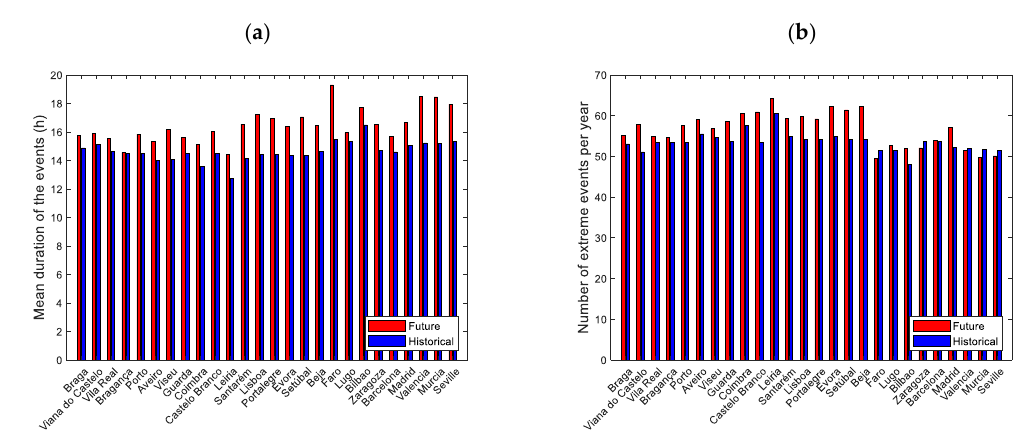
Figure 17. ( a ) Mean duration (hours) of the extreme events of the wind shear and ( b ) number of extreme events per year, for historical (blue) and future (red) climates for all cities.